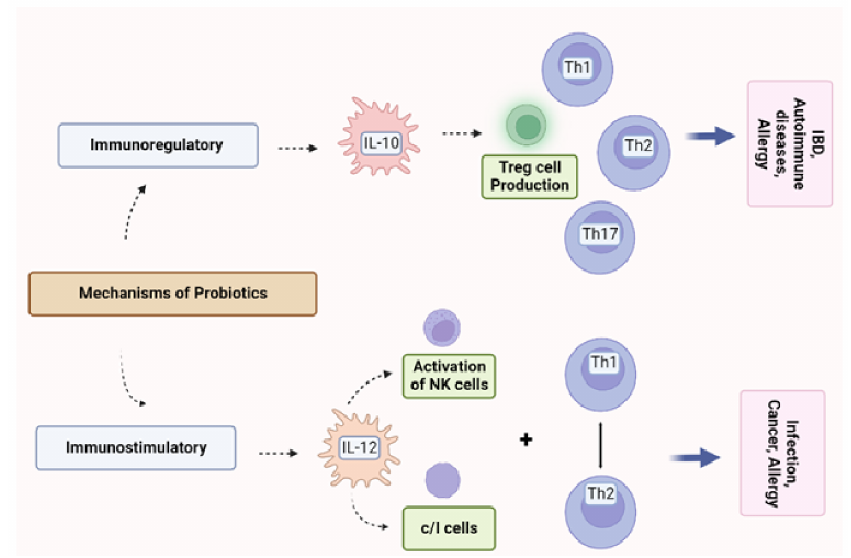
Figure 1. Immune regulation by